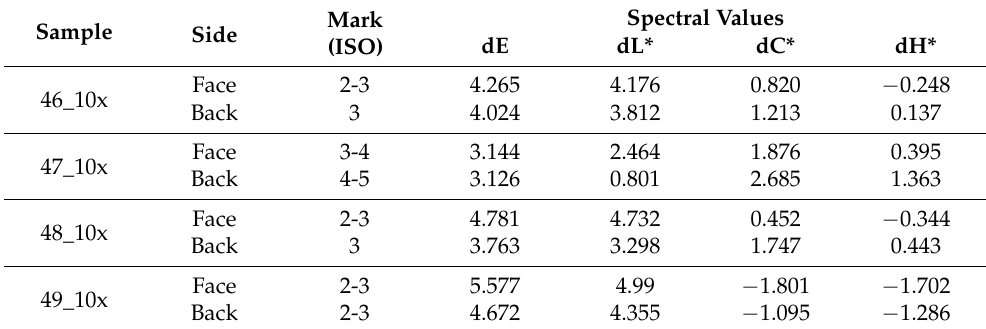
Table 9. Differences in spectral characteristics of washed samples compared to the pristine sample.